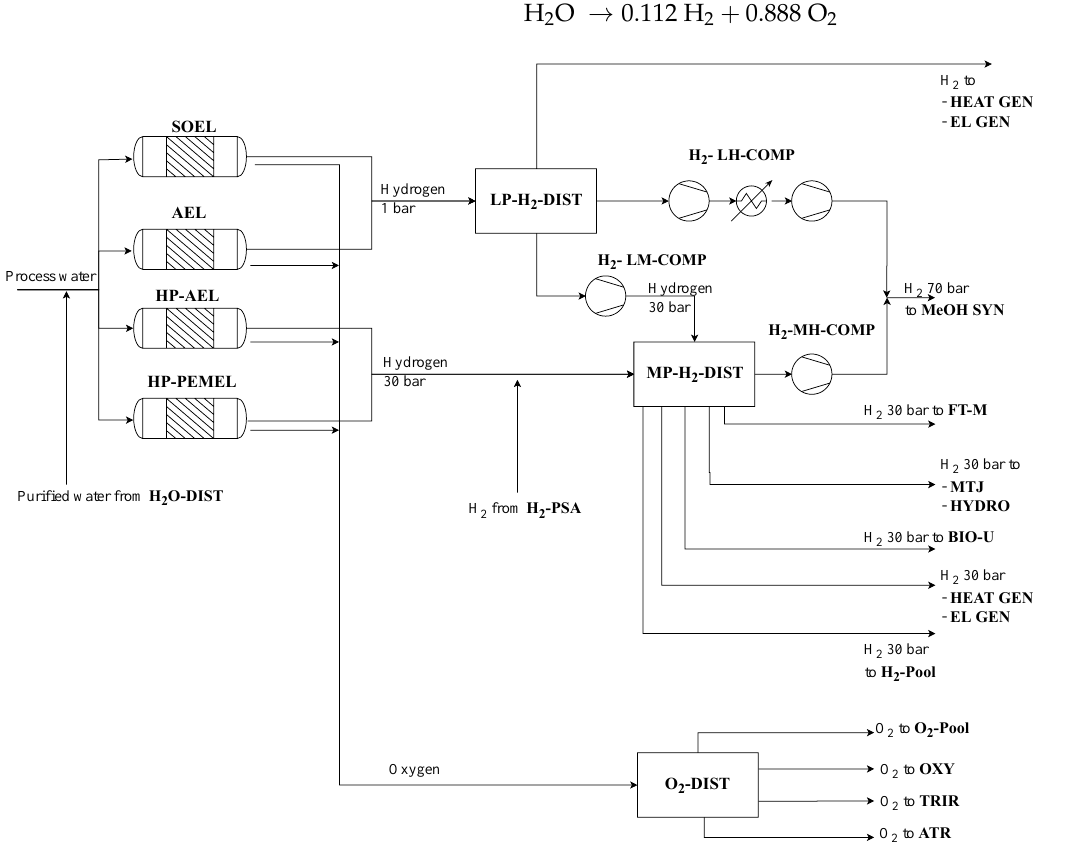
Figure 3. Water electrolysis process section of the superstructure.